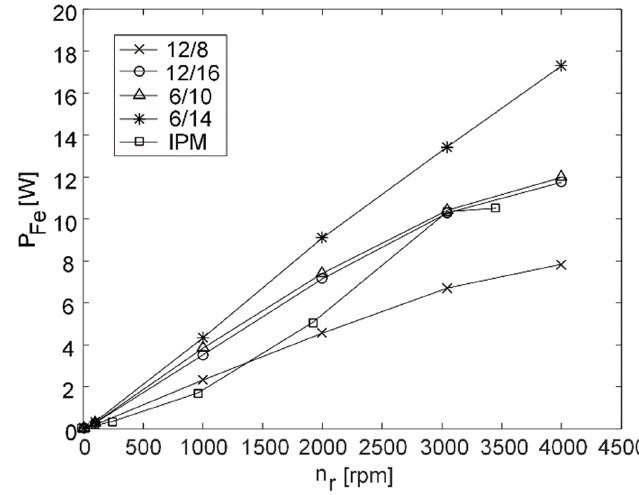
Figure 19. Core losses at nominal current operation.